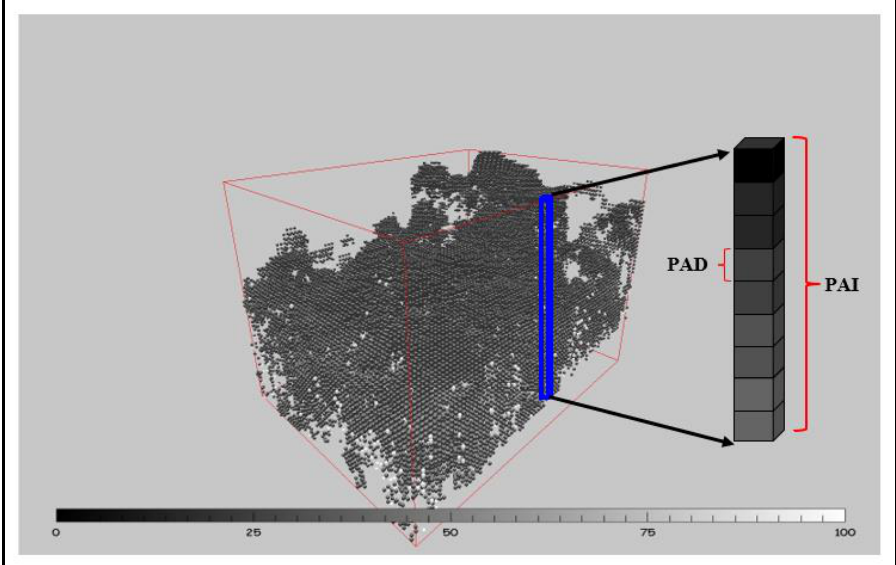
Figure 3. Example of PAD voxelization of LiDAR data point clouds applying AMAPVOX software.